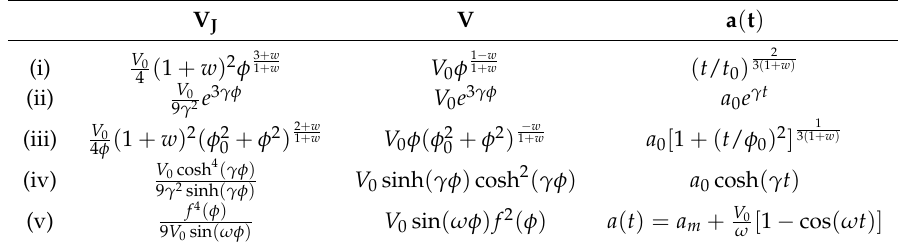
Some solutions of the classical system (12), obtained from [19]. The